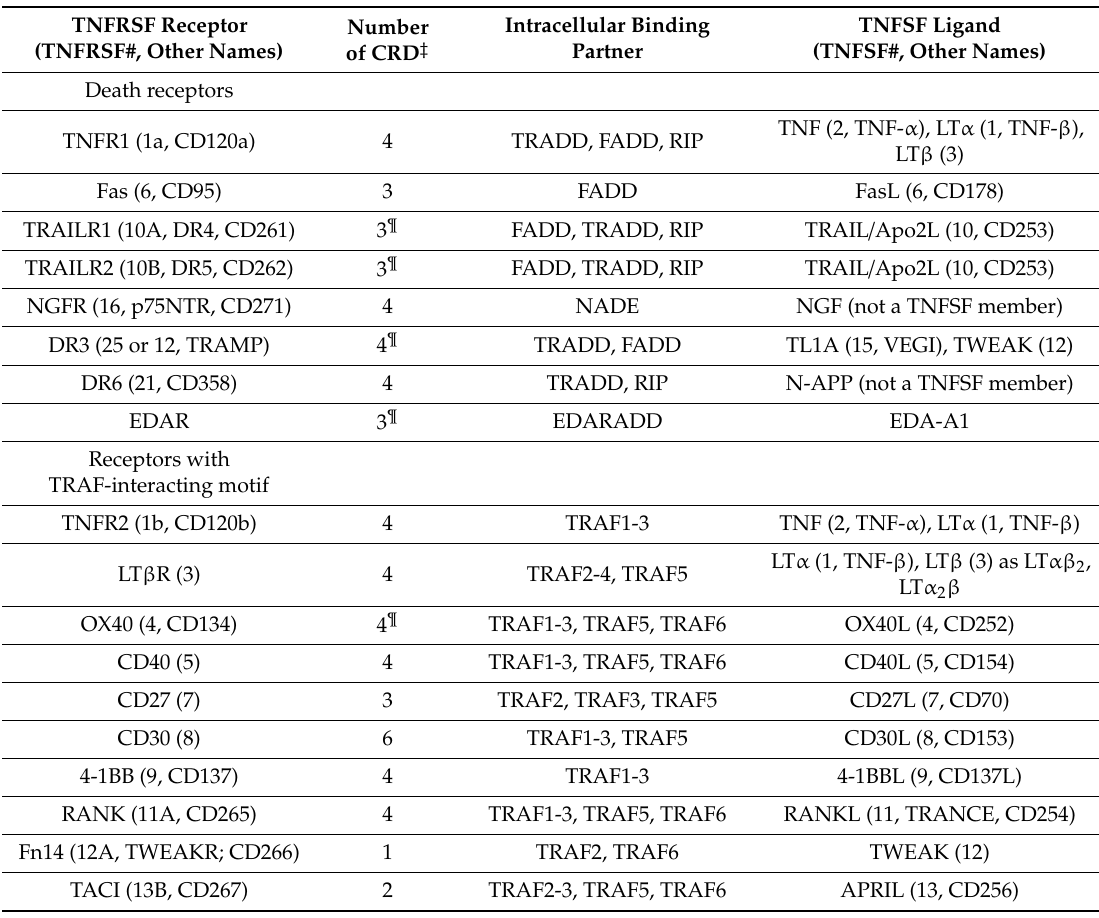
Table 1. Tumor necrosis factor receptor superfamily (TNFRSF) members, their ligands, and intracellular binding